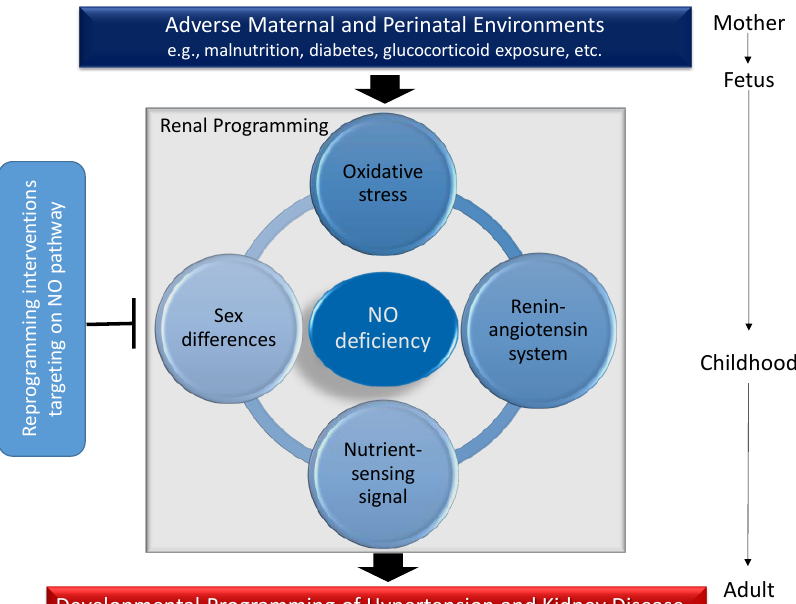
Figure 2. Schema outlining the potential role of NO deficiency on mediating other mechanisms underlying renal programming to cause hypertension and kidney disease in adulthood in response to a variety of early-life insults. Conversely, targeting the NO pathway could be a reprogramming strategy to prevent programmed hypertension and kidney disease by early intervention.